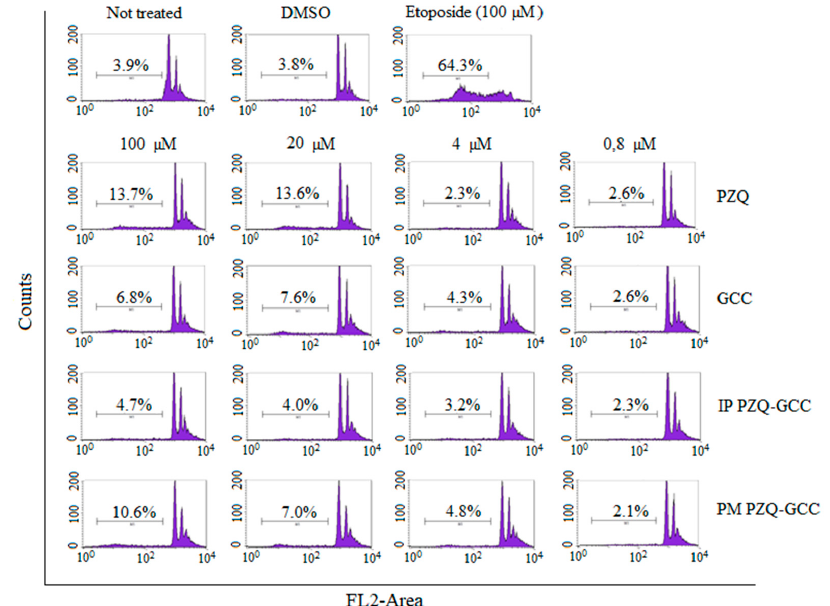
Figure 4. Cell cycle of the HCT116 line treated with the sample studies. The percentages indicate the number of cells in Sub-G1 (apoptotic or